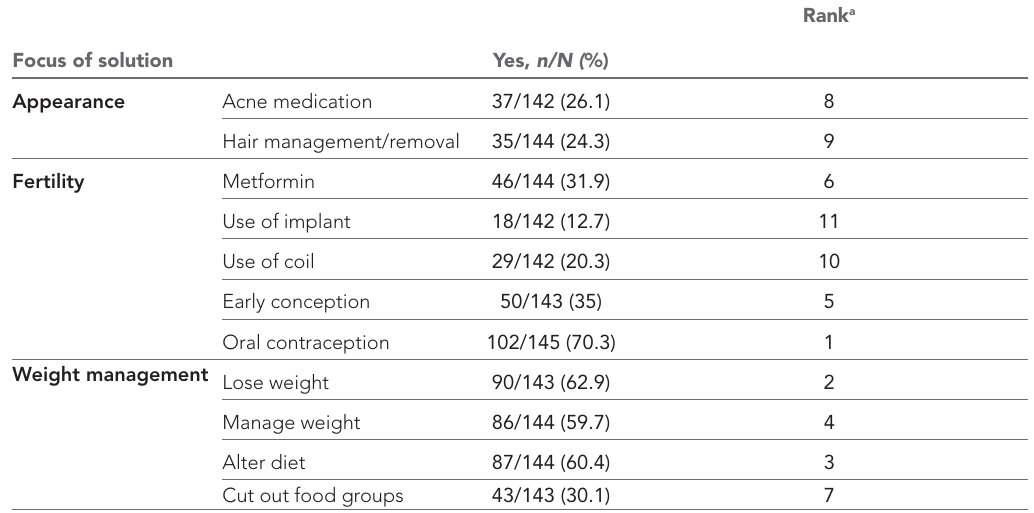
Table 4 Describing the consultation language used during diagnosis: focus of the solution